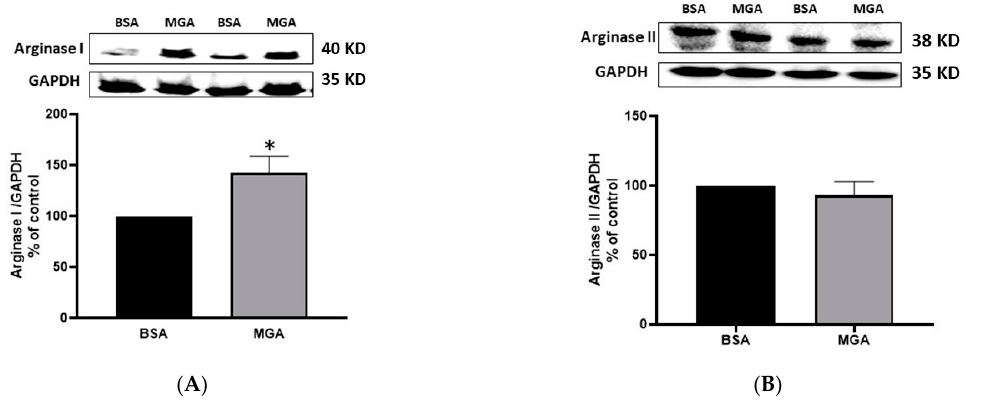
Figure 2. Effect of MGA on arginase expression. ( A ) Immunoblotting analysis of arginase I showing increased expression due to MGA treatment (100 µM, 24 h) as compared to BSA (100 µM, 24 h). ( B ) Immunoblotting analysis of arginase II showing no change in expression after MGA treatment (100 µ M, 24 h) as compared to BSA (100 µ M, 24 h). Values are expressed as means ± SE from 5 independent experiments carried out in triplicates. * p < 0.05 vs. MGA.